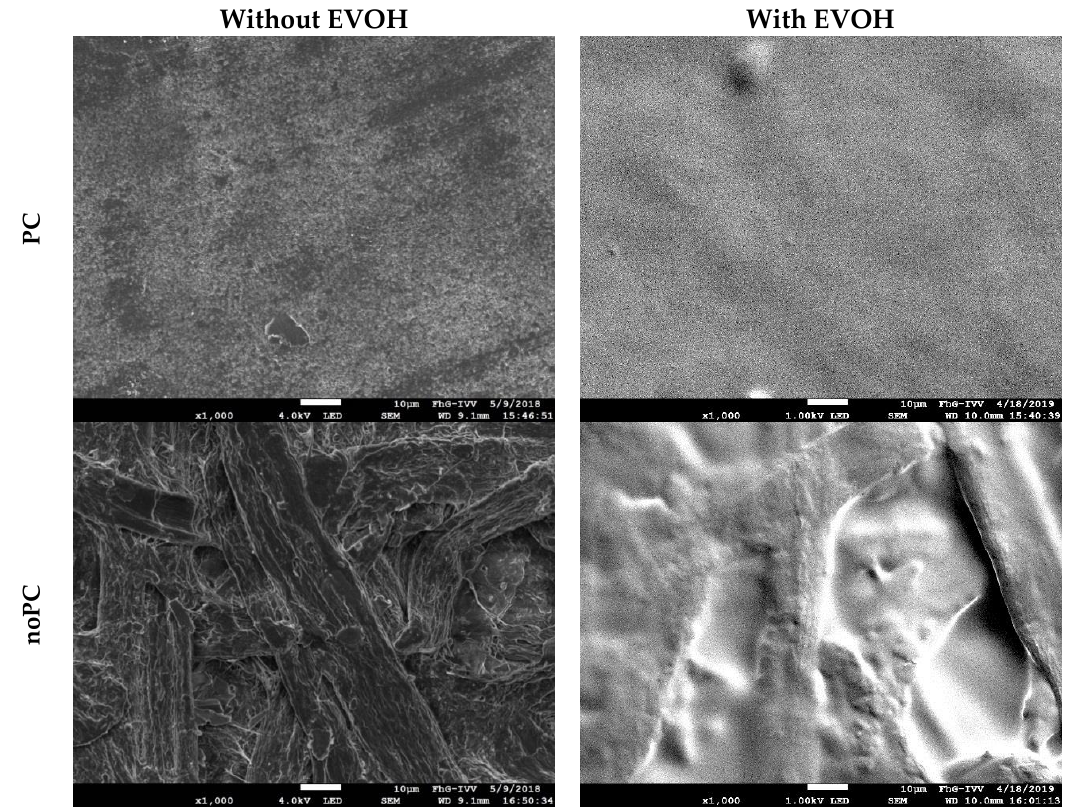
Figure 2. Coating weight at 50% relative humidity. Although in each case the same EVOH coating and the same rod was used, the weight of the EVOH coating was higher on the rougher noPC surface. Roughness values R Z before EVOH coating are shown as numbers above the columns. PC/noPC = paper surface with/without pigment coating. EVOH = ethylene vinyl alcohol lacquer.